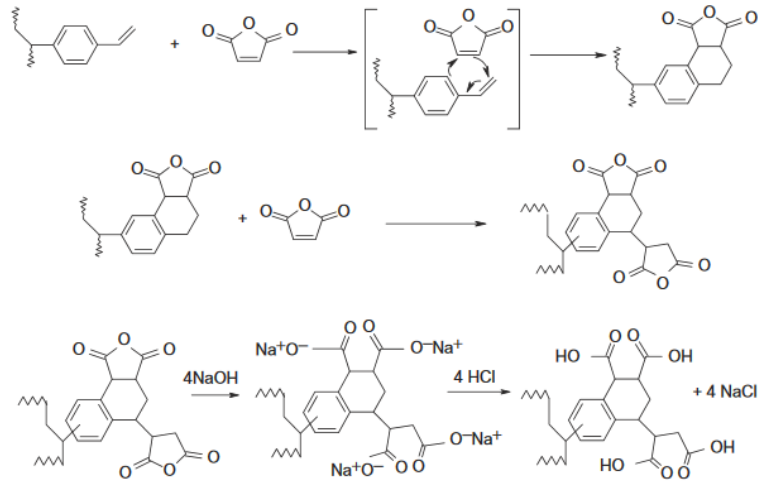
Figure 1. Scheme of poly(divinylbenzene) modification using maleic anhydride [47]. Selected adsorbent has a predominantly mesoporous structure with an average pore size 6.62 nm and a total pore volume 0.96. Its scanning electron microscope (SEM) micro- graphs (ZEISS, Zeiss EVO LS 15, Oberkochen, Germany) are shown in Figure 2. The studied polymeric microspheres are characterized by a well-developed surface area (578 m 2 g − 1 ) and good water regain (2.54 g g − 1 ), which have a direct impact on the adsorption efficiency.